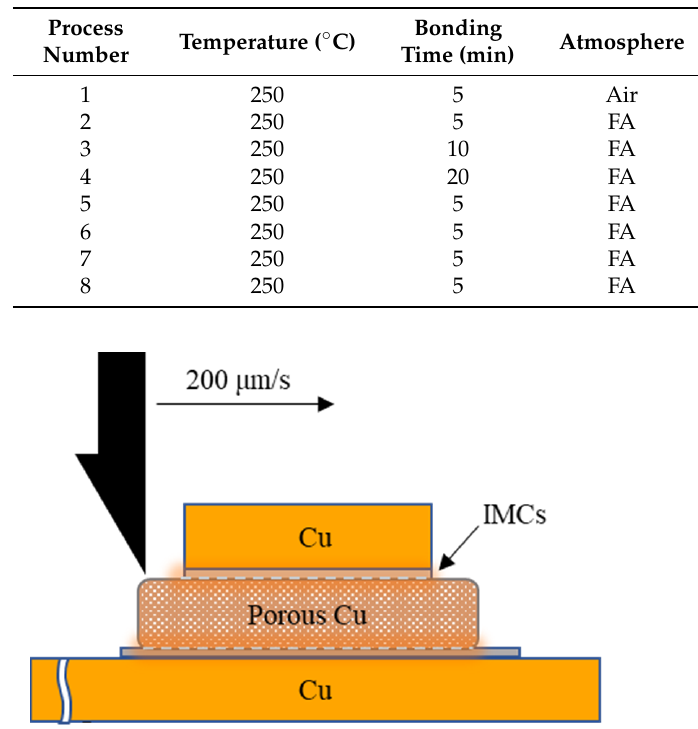
Table 1. Summary of heating processes.